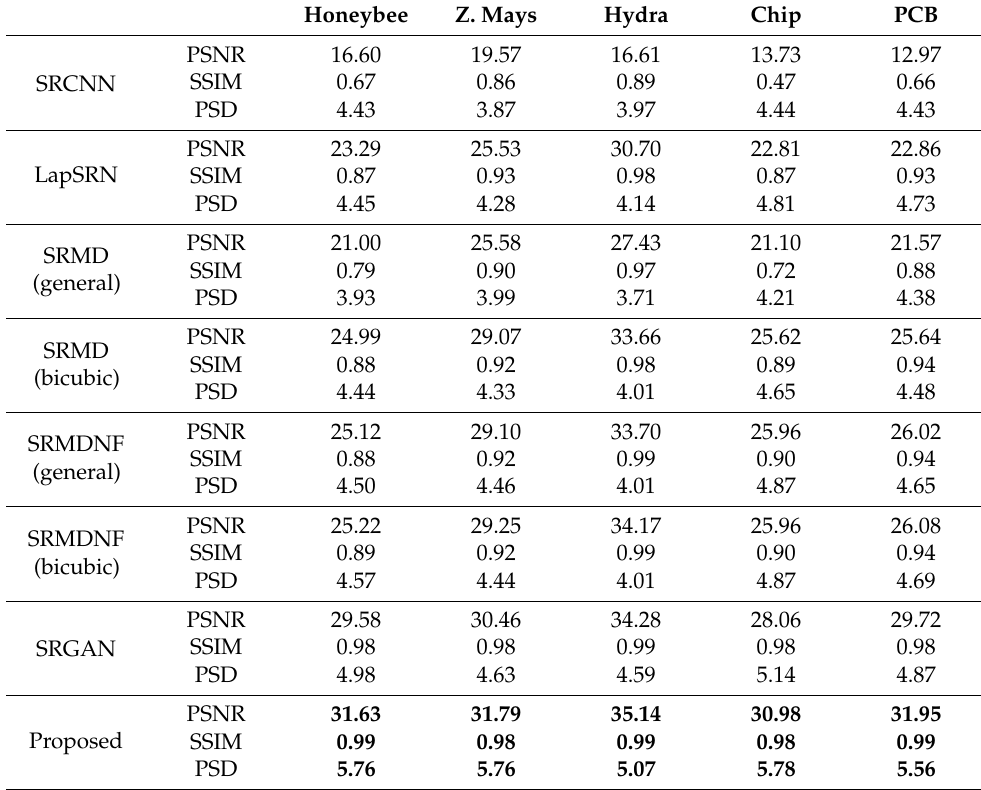
Table 2. PSNR, SSIM, and PSD comparison of the super resolved OVI ( × 4) using different algorithms. The proposed algorithm performs better in all cases.